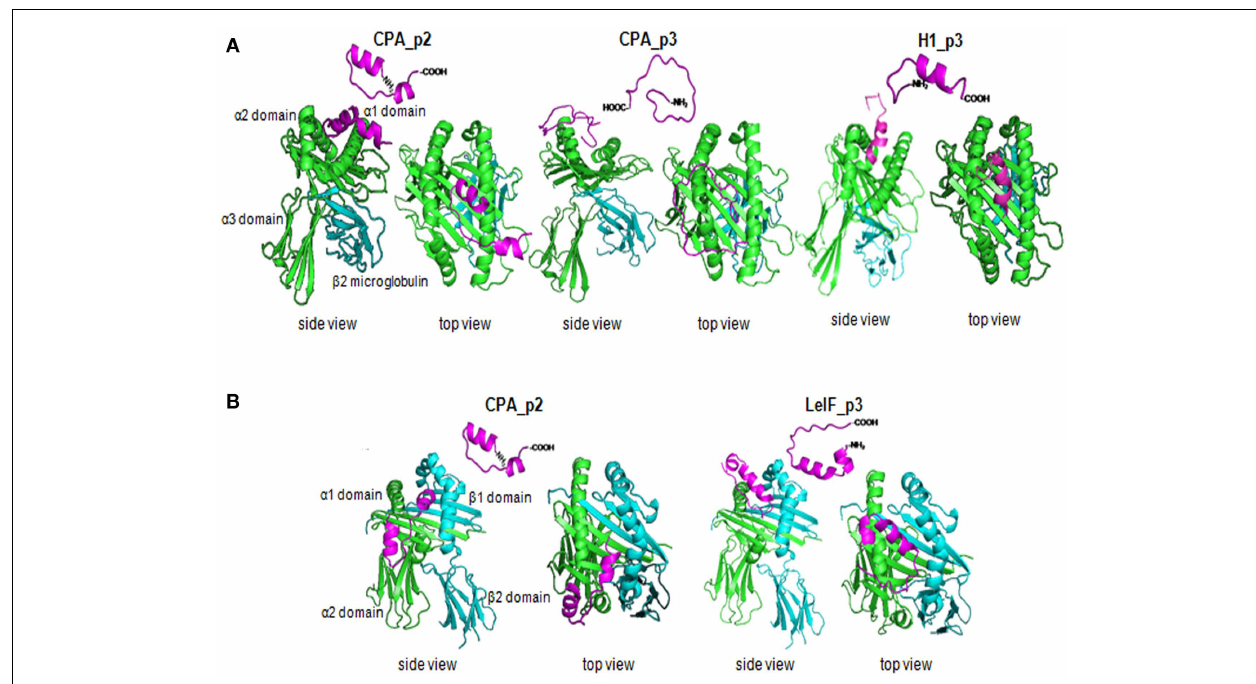
peptides CPA_p2 and LeIF_p3. Candidate peptides were predicted to locate onto the peptide-binding cleft of the HLA molecules by using ClusPro program.The side and top view are shown, the α strands were shown in green, the β strands in blue, and the multi-epitope peptides in magenta.